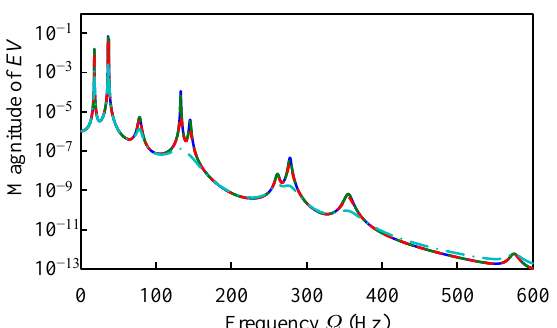
k s = 40,000 kN/m,